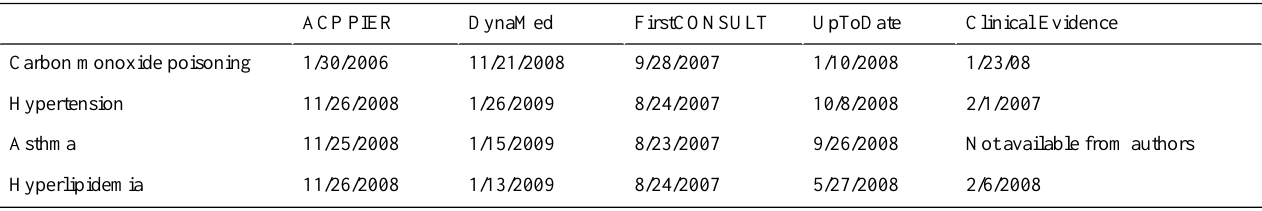
Table 2. Last updated date (day/month/year) for topics within point-of-care products